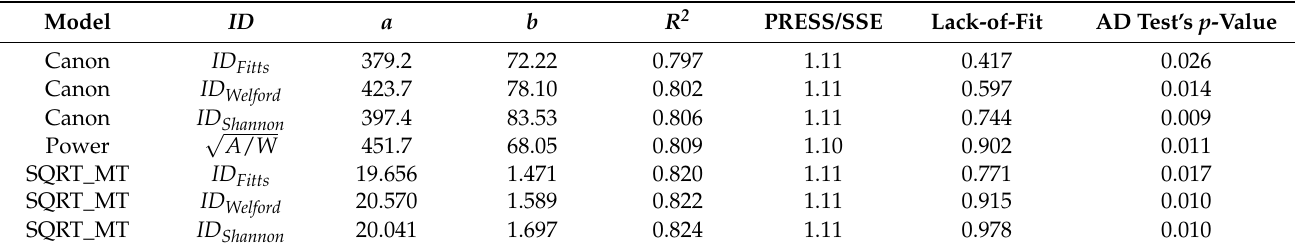
Table 9. Regression analysis using data for all amplitudes. The R-squared values were much lower than the value reported in the literature, possibly due to the equal observations of each ID . Additionally, the normality in all models was significant.